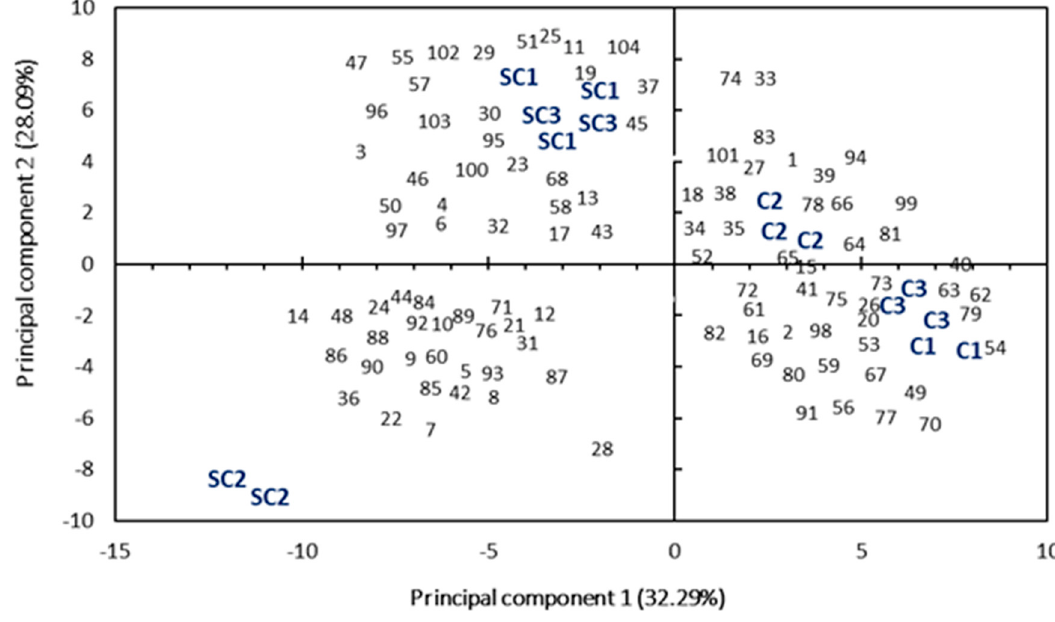
Figure 2. Principal component analysis (PCA), loadings (volatile compounds), and score plot (NC and C processes) of PC1 and PC2, from all volatile compounds in treatments.